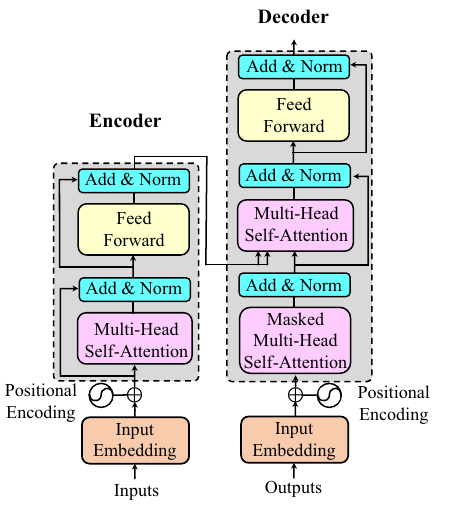
Figure 2. Architecture of the standard Transformer 19